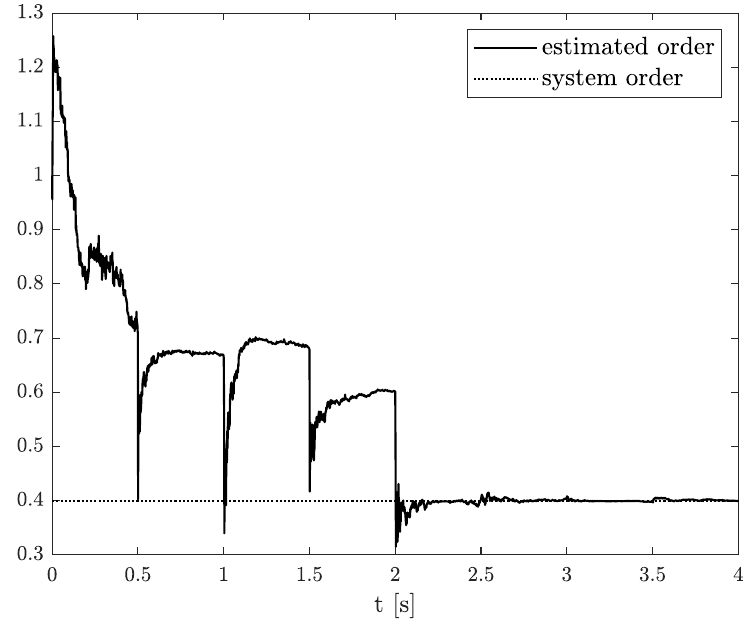
Figure 6. Original and estimated order from Example 1.